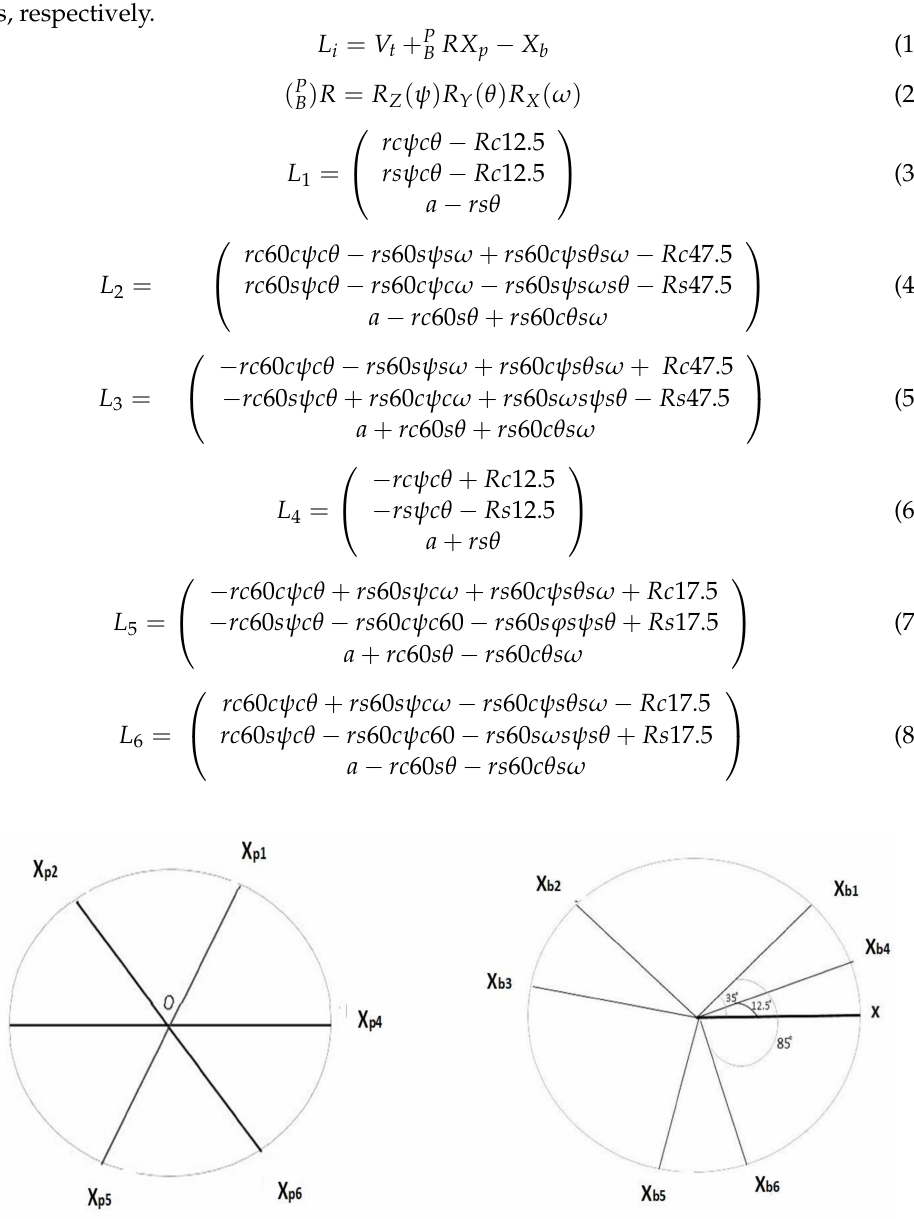
Figure 4. Angle distribution on the movable top plate and fixed base